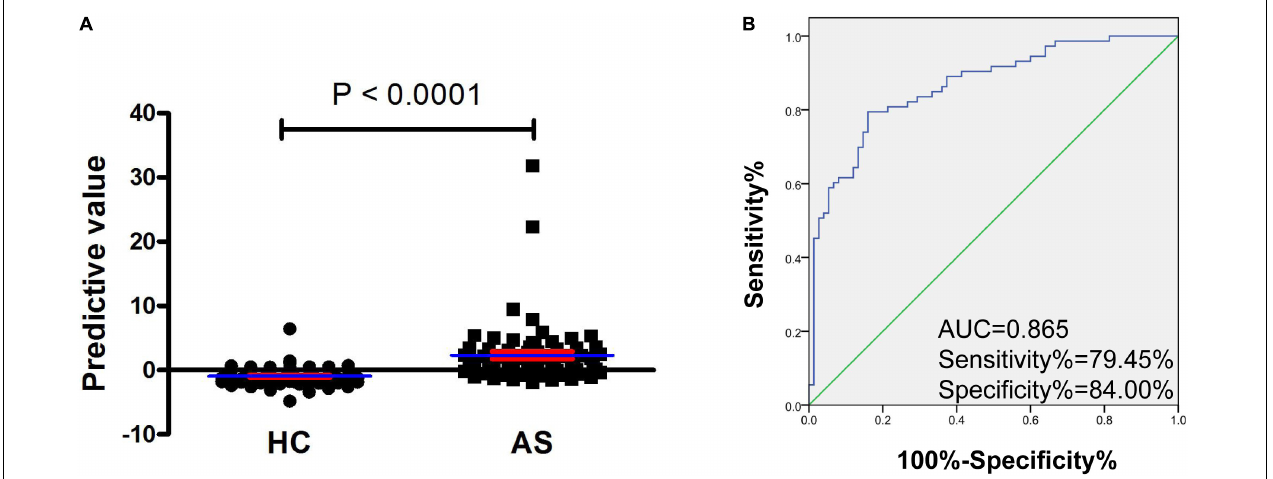
FIGURE 4 | Increased predictive model based on mRNA YTHDF2 and SII has an improvement value for AS. (A) The predictive value between patients with AS and HC. Blue and red lines indicates mean and standard error, respectively. (B) ROC analysis of predictive model. Blue and green lines indicates ROC and line of identity, respectively. AS, ankylosing spondylitis; HC, healthy control; ROC, receiver operating characteristic; SII, systemic immune-inflammation index; YTHDF2, YT521-B homology domains 2.